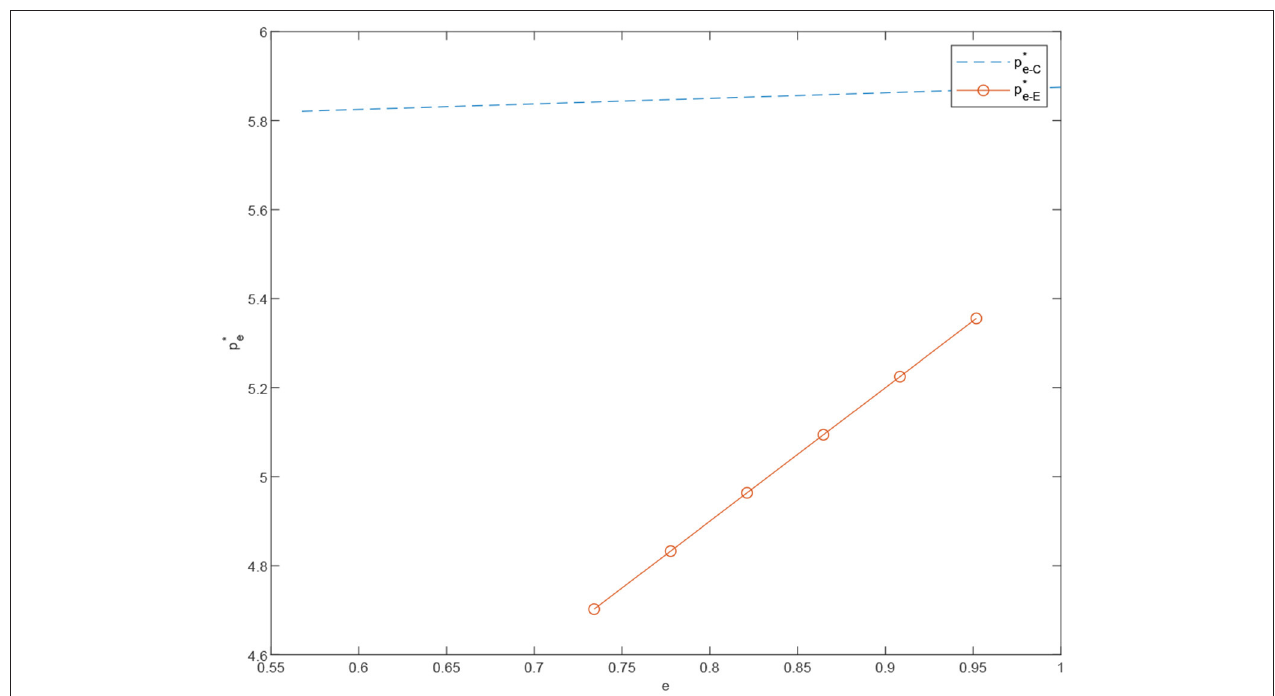
FIGURE 2 | The price of the customized product under the centralized scenario p ∗ m − C vs. the price of the customized product under the decentralized scenario p ∗ m − E .